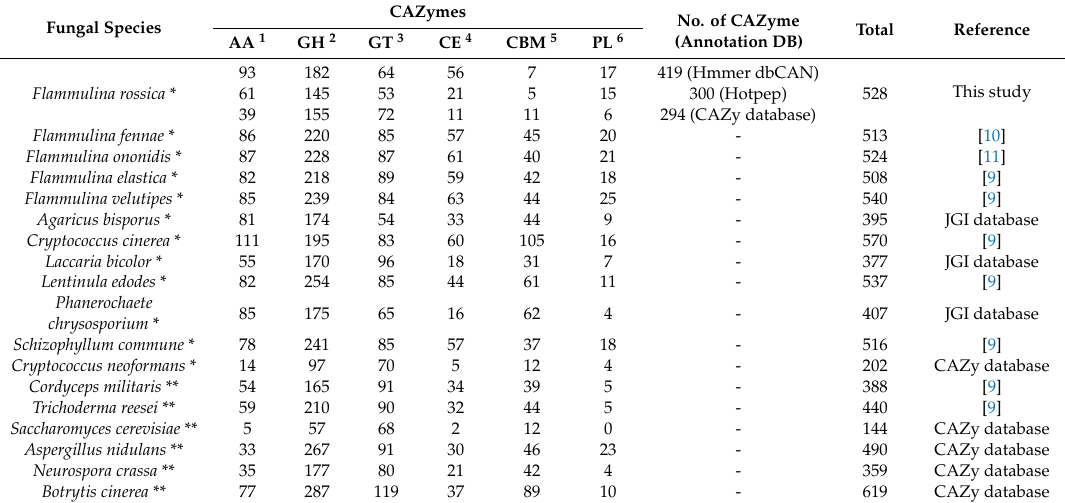
Table 4. CAZymes of Flammulina rossica and other fungal